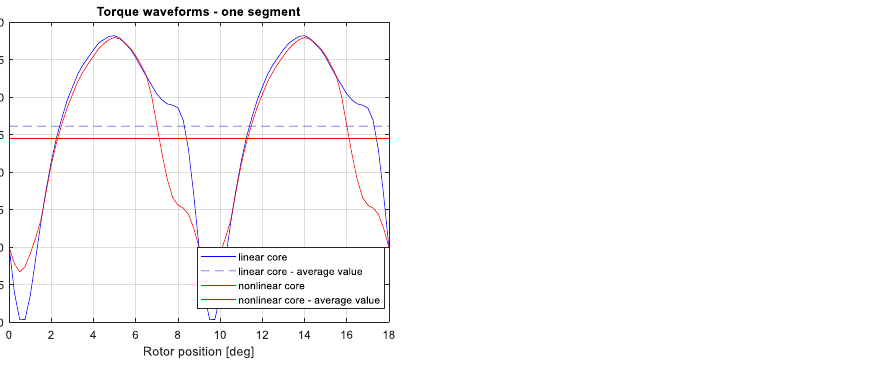
Figure 8. Comparison of torque waveform as a function of rotor position angle for the linear core and nonlinear core.